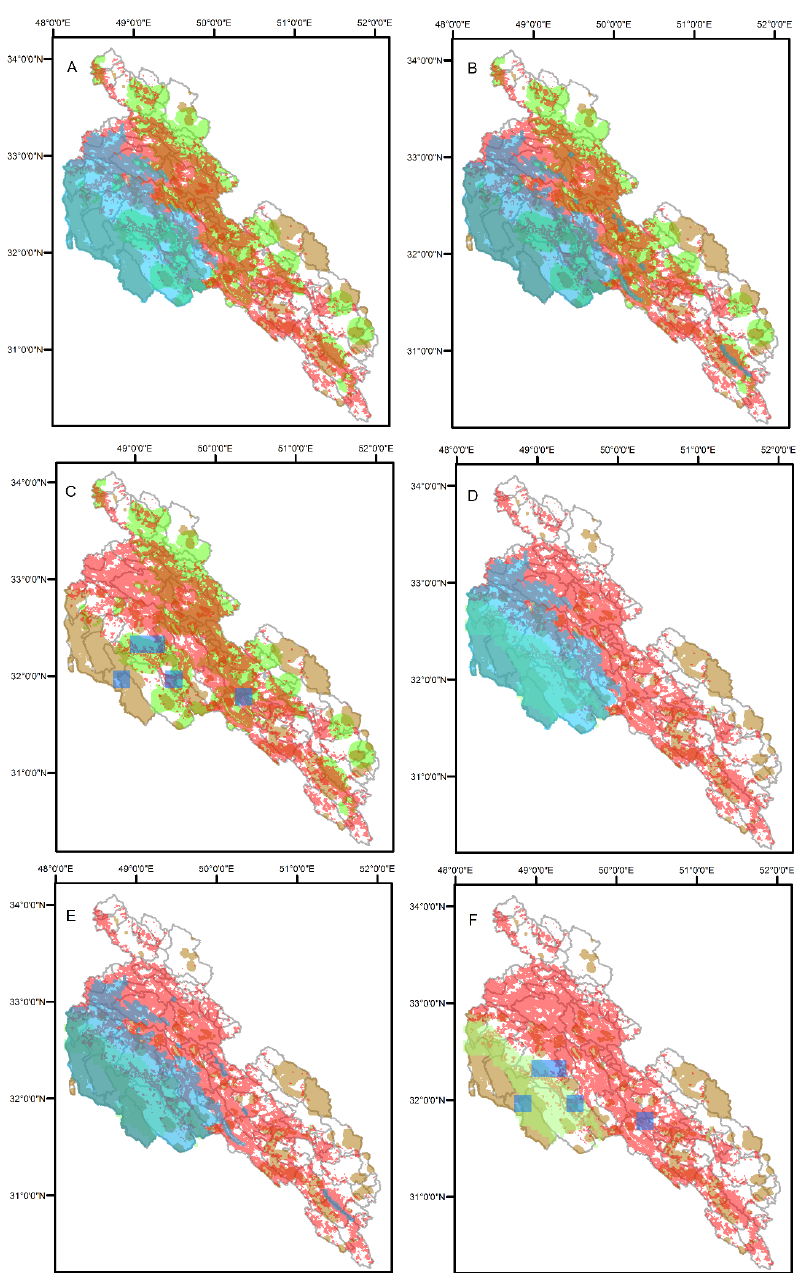
Figure 5. Hotspots maps overlaid with spatial-temporal dimensions (Karun, Iran, 2000–2016). Hotspots (HS) or emerging hotspots (EHS) of rainfall (blue), connectivity (red), soil erodibility (brown), and vegetation (green) are plotted. Connectivity HS, soil erodibility HS, and vegetation EHS are from minimum data inventory (global datasets). Rainfall HS ( A , B , D , E ) are derived from minimum data inventory, and rainfall EHS from available data inventory ( C , F ). ( A , D ) Monthly rainfall depth in most rainy month according to WorldClim 2.0 (January, [53]). ( B , E ) Global mean rainfall erosivity [56]. ( C , F ) Measured daily rainfall (2000–2016, 29 stations, provided by Khuzestan Water and Power Authority and Iran Water Resources Management Co, EHS patterns in period 2000–2016 were calculated relative to the end of the last hydrological year 2016). ( A – C ) EHS of low biomass for the period with lowest greening at the beginning of a rainy season. ( A – C ) EHS patterns calculated relative to the end of October 2016 from MODIS NDVI) are plotted. ( D – F ) Vegetation EHS plot a month later, before the rainiest month (December, according to meteorological data) starts (EHS patterns calculated relative to the end beginning of December